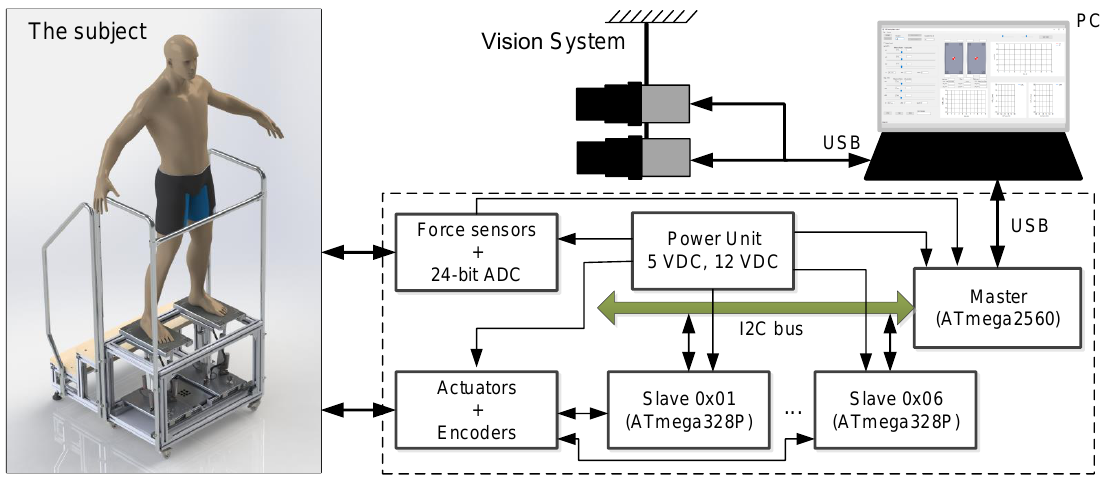
Figure 4. System for evaluation and compensation of leg ength discrepancy for human body